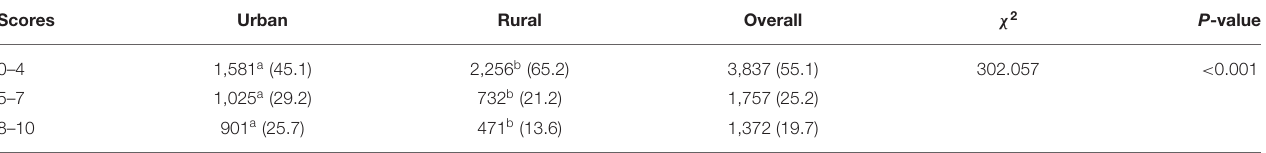
TABLE 3 | Distribution of smoking-related knowledge